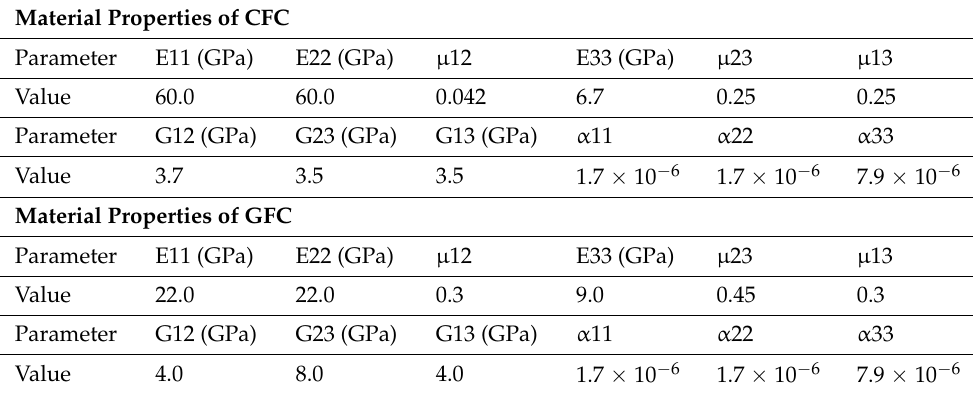
Table 1. The material properties of the carbon fiber cloth (CFC) and the glass fiber cloth (GFC). The data were provided by the manufacturers.